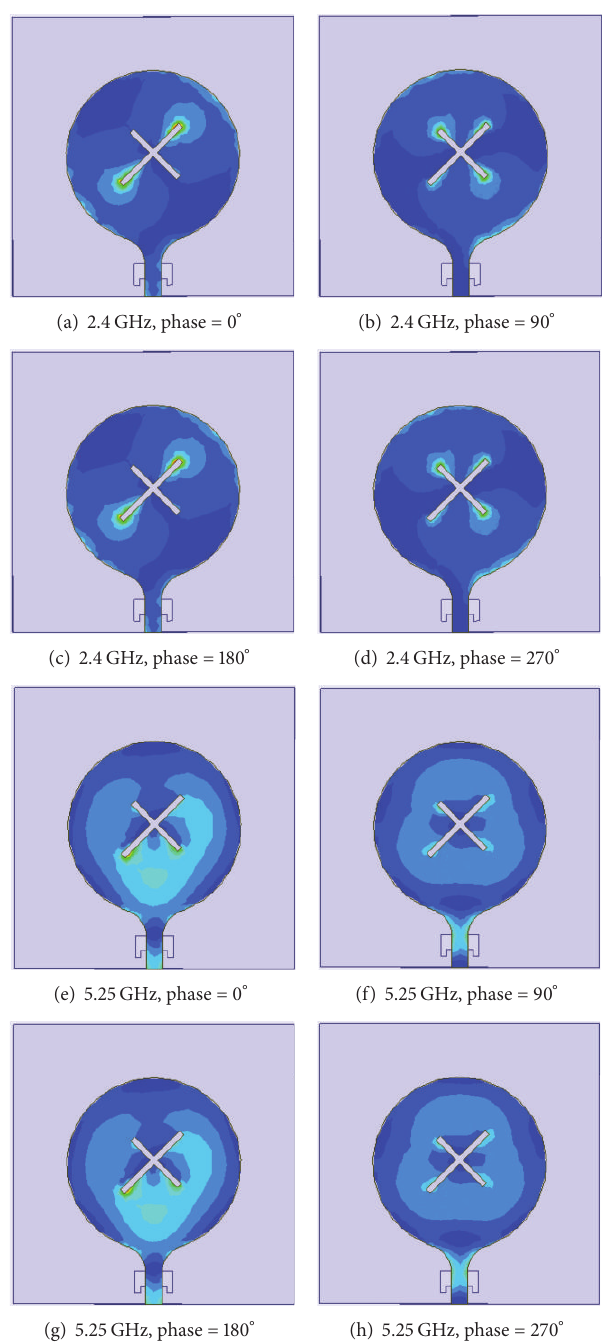
Figure 9: Current distribution at 2.4 and 5.25 GHz resonant frequencies for different